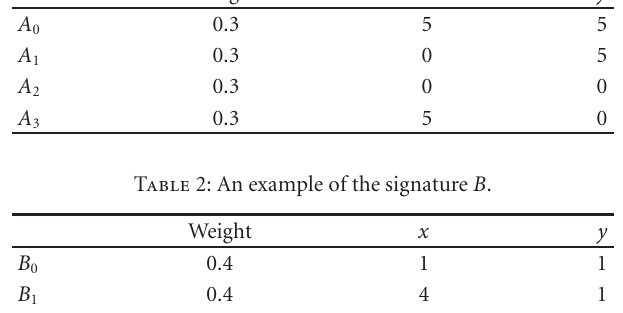
Figure 2: Optimized flow.